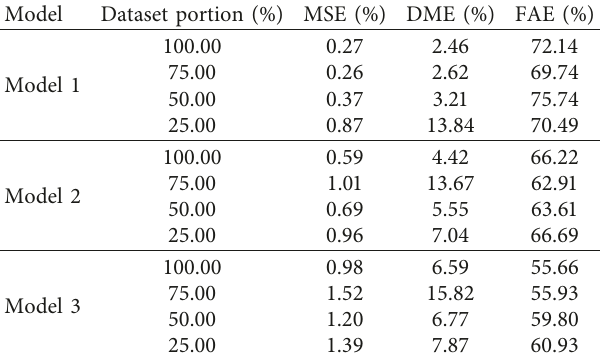
Table 7: Model performance comparison for different training set sizes.